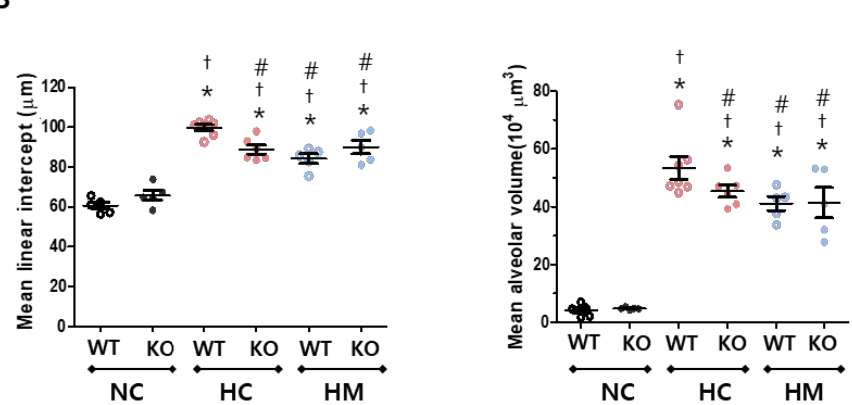
Figure 3. Alveolarization in wild-type and FPR2 − / − mice. ( A ) Hematoxylin and Eosin-stained sections showing representative morphology of rat lungs (scale bar, 100 µ m). ( B ) Mean linear intercept (μm) and mean alveolar volume (×10 4 μm 3 ) as markers of the degree of alveolarization. Data are given as mean ± SEM. * p < 0.05 vs. NC in WT. † p < 0.05 vs. NC in KO. # p < 0.05 vs. HC in WT. WT, wild − type mouse; KO, FPR2 −/− mouse; NC, normoxia control; HC, hyperoxia control; HM, hyperoxia with intratracheal transplantation of human umbilical cord blood − derived MSC transplantation. MSC